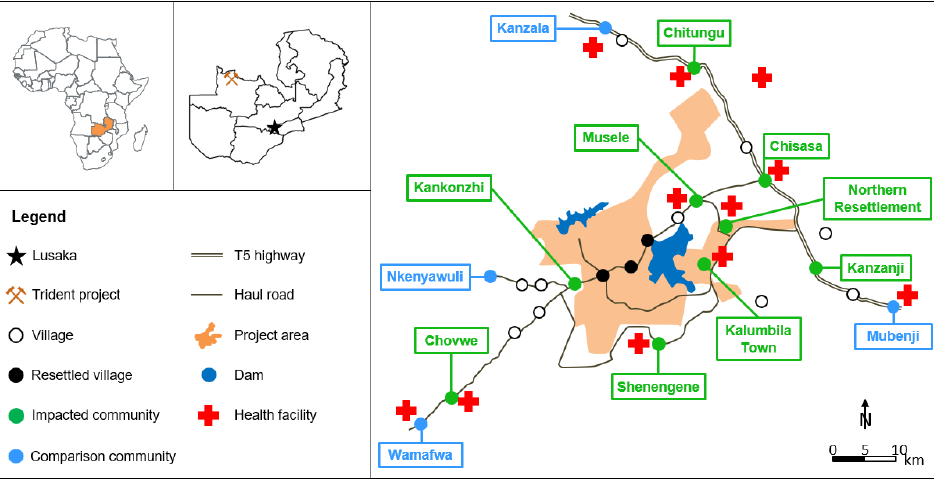
Figure 1. Map of the study area, Kalumbila district, Zambia.